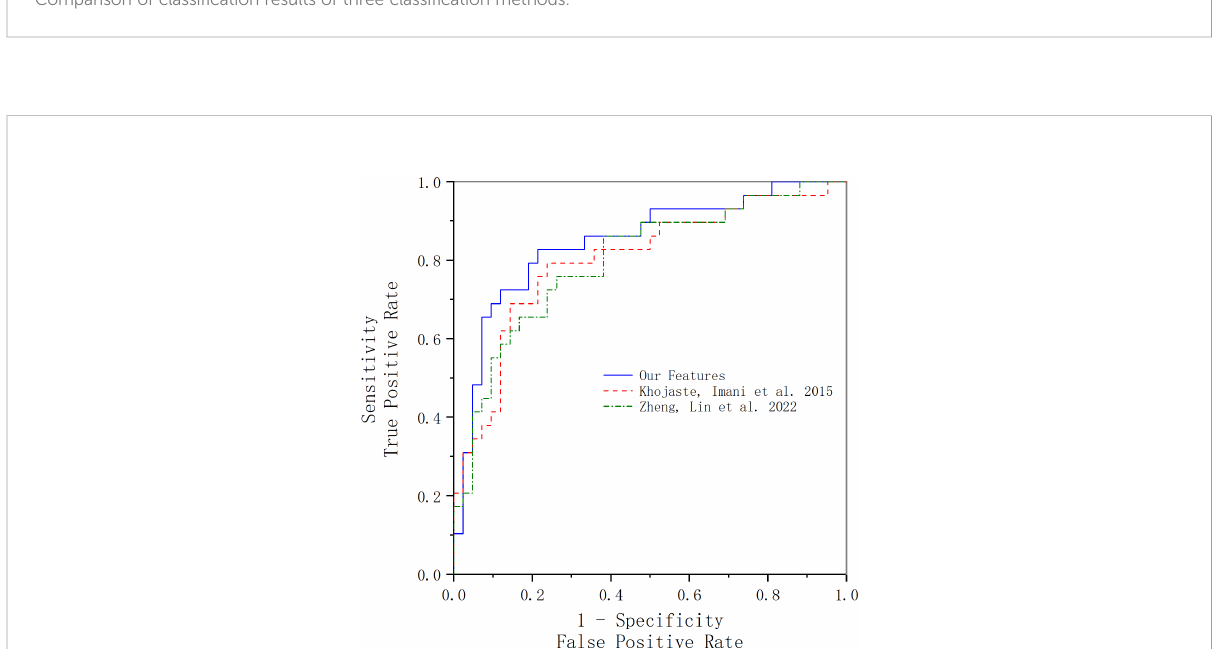
FIGURE 6 ROC curve acquired using our features and Khojaste and Imani ’ s features. The blue line represents the ROC curve acquired using our features; the red line represents the ROC curve acquired using Khojaste and Imani ’ s features; the green line represents the ROC curve acquired using Zheng and Lin ’ s features.